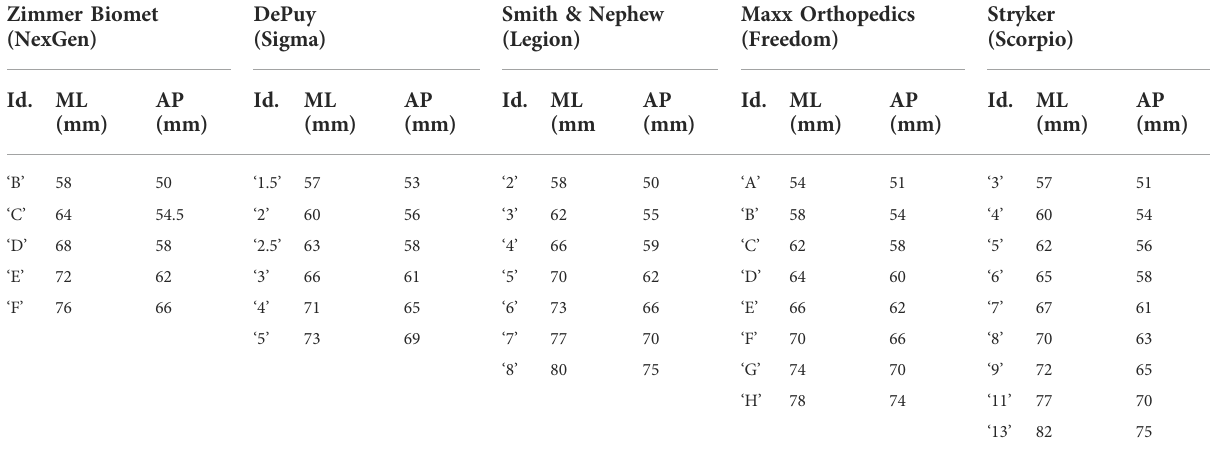
TABLE 2 Femurcomponent sizing chart,detailingthe manufacturer, model, size identi fi er, and ML/AP dimensions(obtained from respective surgical technique manuals). Zimmer Biomet DePuy Smith & Nephew (NexGen) (Sigma)